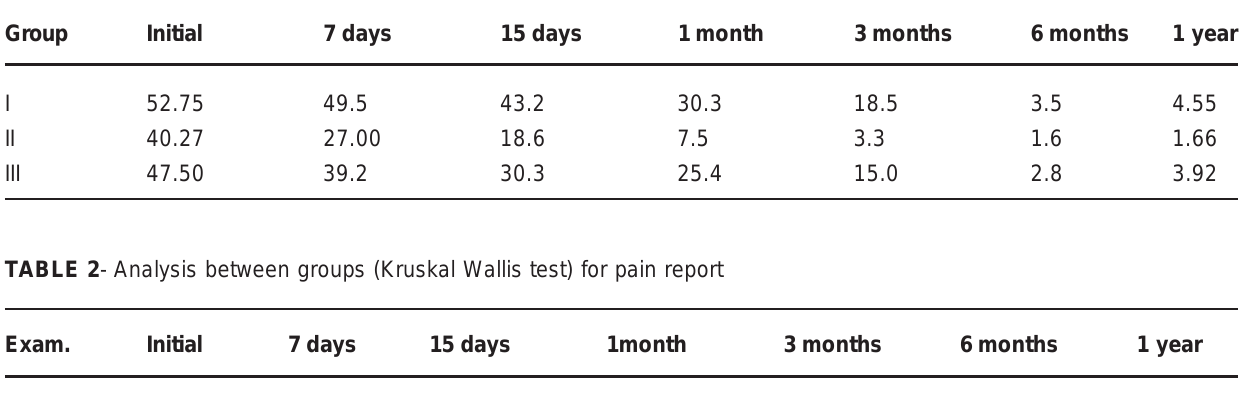
TABLE 1 - Mean VAS figures (mm) for different groups